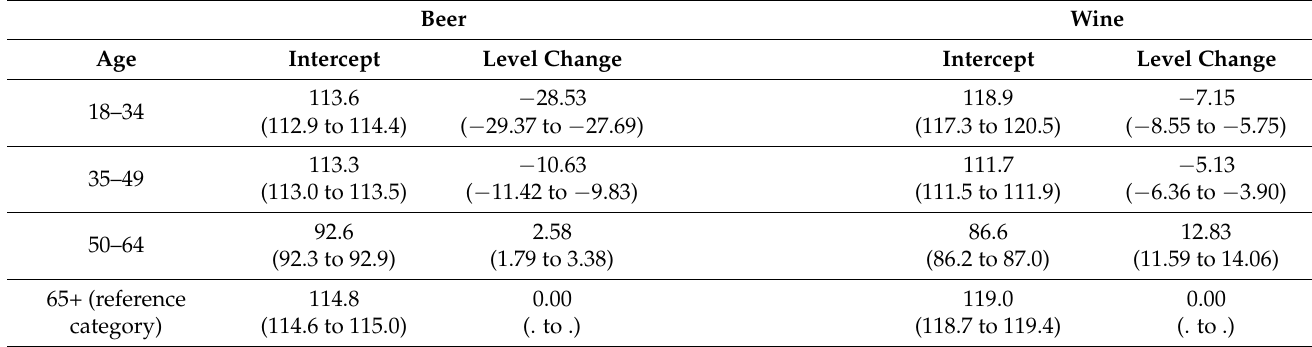
Table 2. Unstandardized coefficients (95% CI) from interrupted time-series regression models accord- ing to sociodemographic variables for beer and wine. The model includes, as independent variables, the event, the sociodemographic category, and the interaction term event*sociodemographic category. Thus, the coefficients for the level changes represent the differences in changes between the stated category and the reference